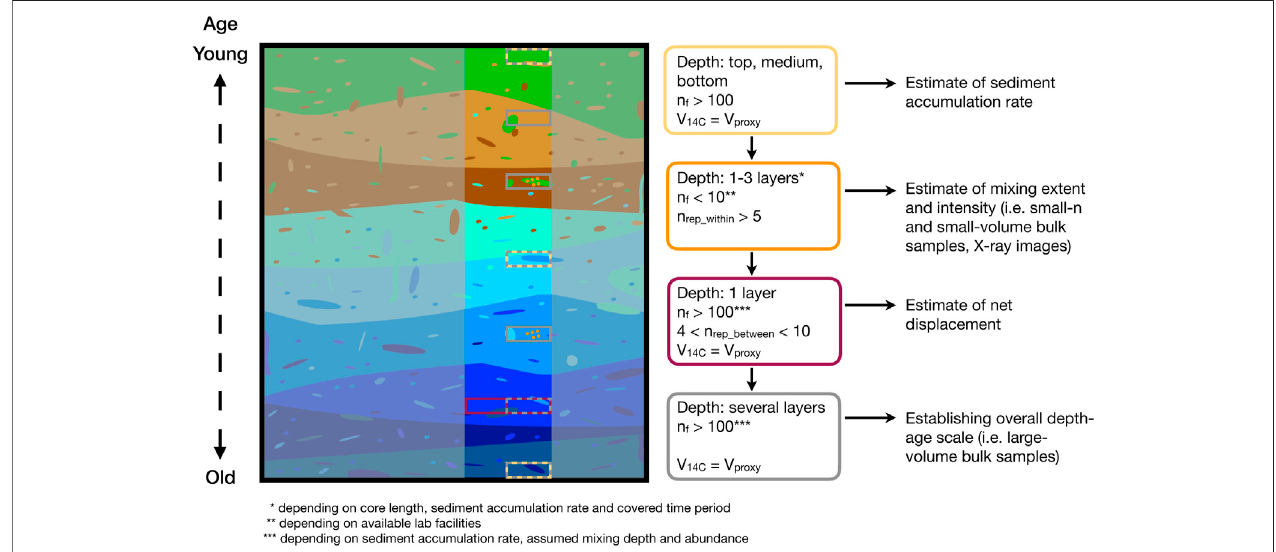
FIGURE9| Overviewandillustrationsuggestedstepstowardsanimprovedsamplingprotocolforasinglecore.Theboxescorrespondtoproposedsamplesinthe 2D sketch and contain suggestions for different sample types with the depth and the number of layers to samples, the ideal number of specimens n f , the number of replicates n rep − within from one sample or the number of replicated samples from one depth n rep − between as well as the physical volume of a sample V 14C . The sample volume should be similar or the same as the volume used for the proxy reconstruction (i.e. 10-20 cm 3 ). The second row indicates the information which can be derived from each individual sample type and it indicates to which of the samples from our study it can be